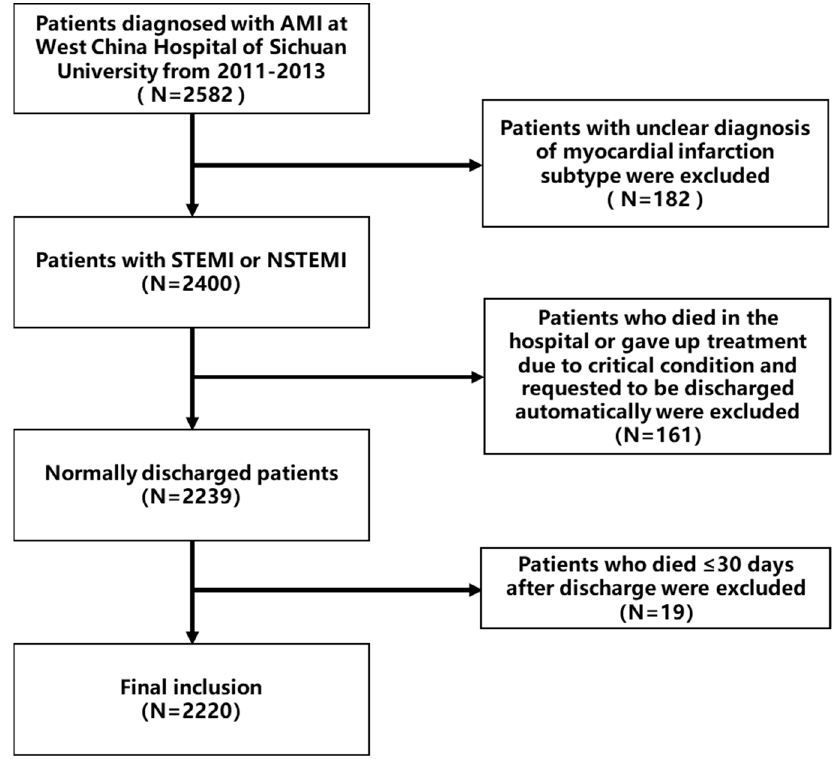
Figure 1. Patient selection process.